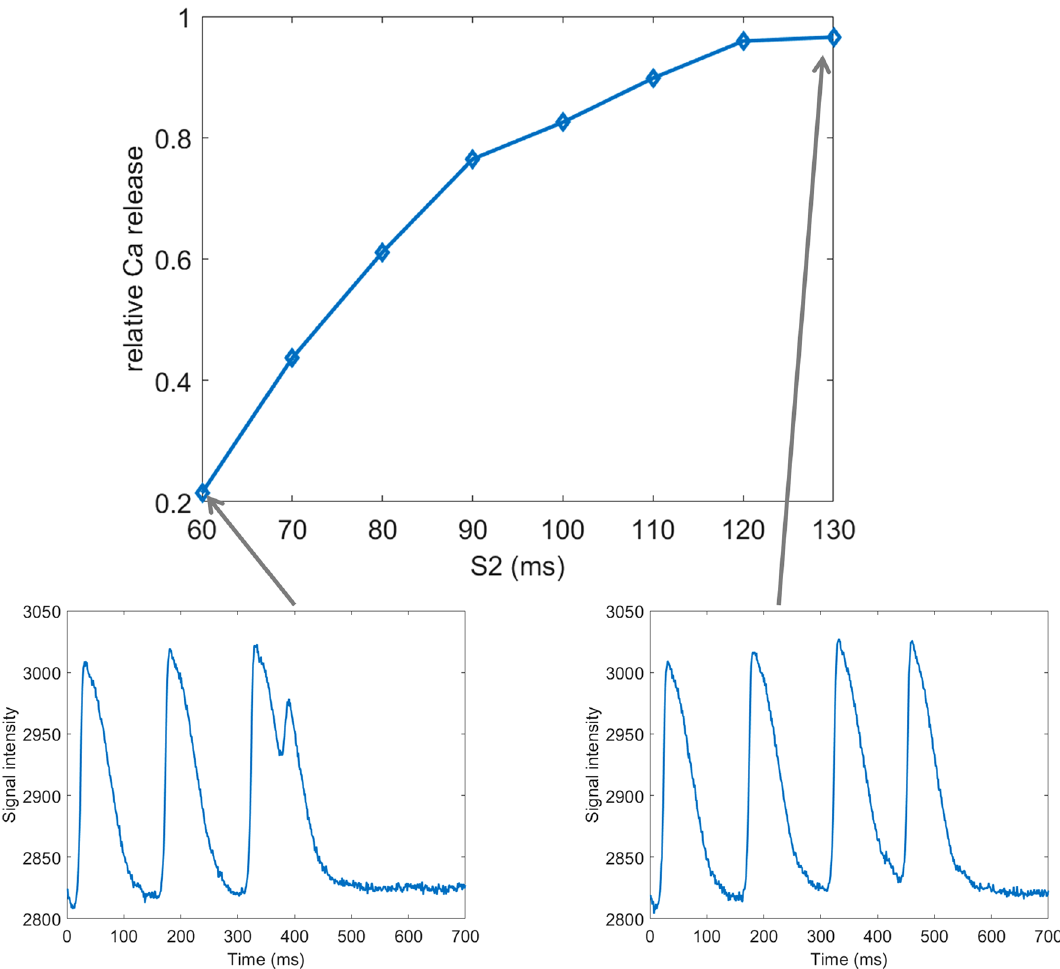
Figure 7. An example of CaT amplitude restitution in S1-S2 protocol. In the top image is shown the relative CaT amplitude of the S2 stimulus versus S1 stimuli, demonstrating that for short S2 coupling interval, the CaT amplitude is reduced. CaT amplitude is defined as the upstroke amplitude (i.e. from the start of the CaT to the peak). Below the restitution curve are two examples of traces from which the curve was extracted: for S2 = 60 ms and S2 = 130 ms. The S1 coupling interval was 150